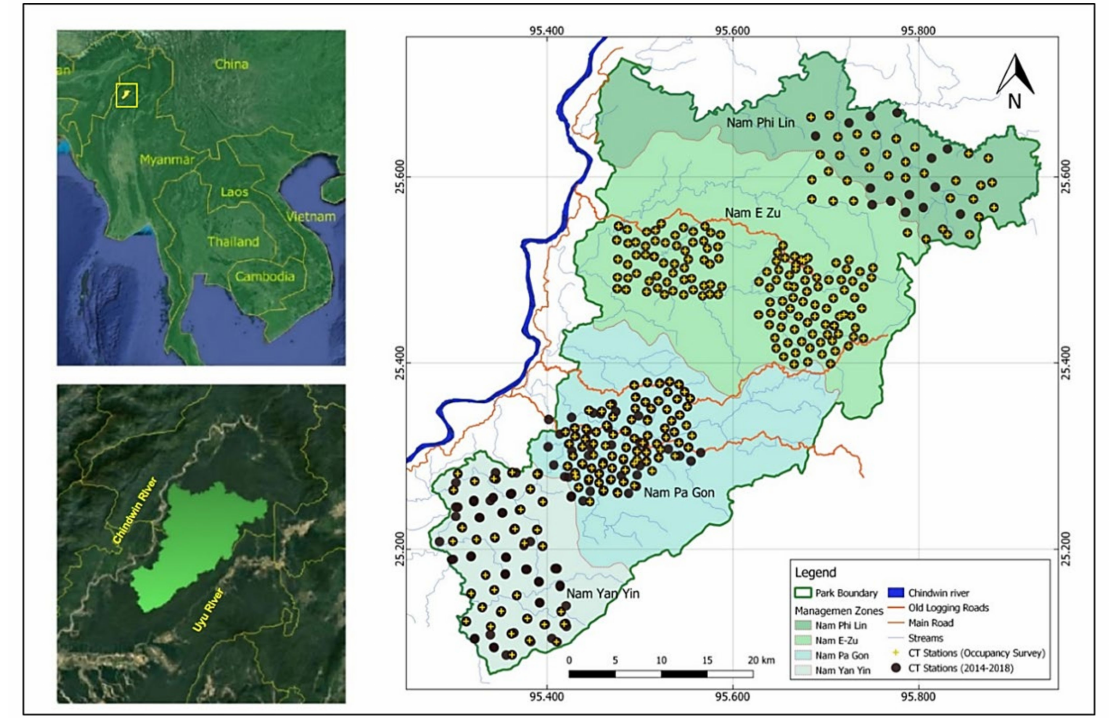
Figure 2. Camera trap surveys in Htamanthi Wildlife Sanctuary. A total of 525 camera trap stations (black dots) have been deployed and surveyed across the sanctuary (2014–2018); 288 camera stations (yellow stars) were used in space use